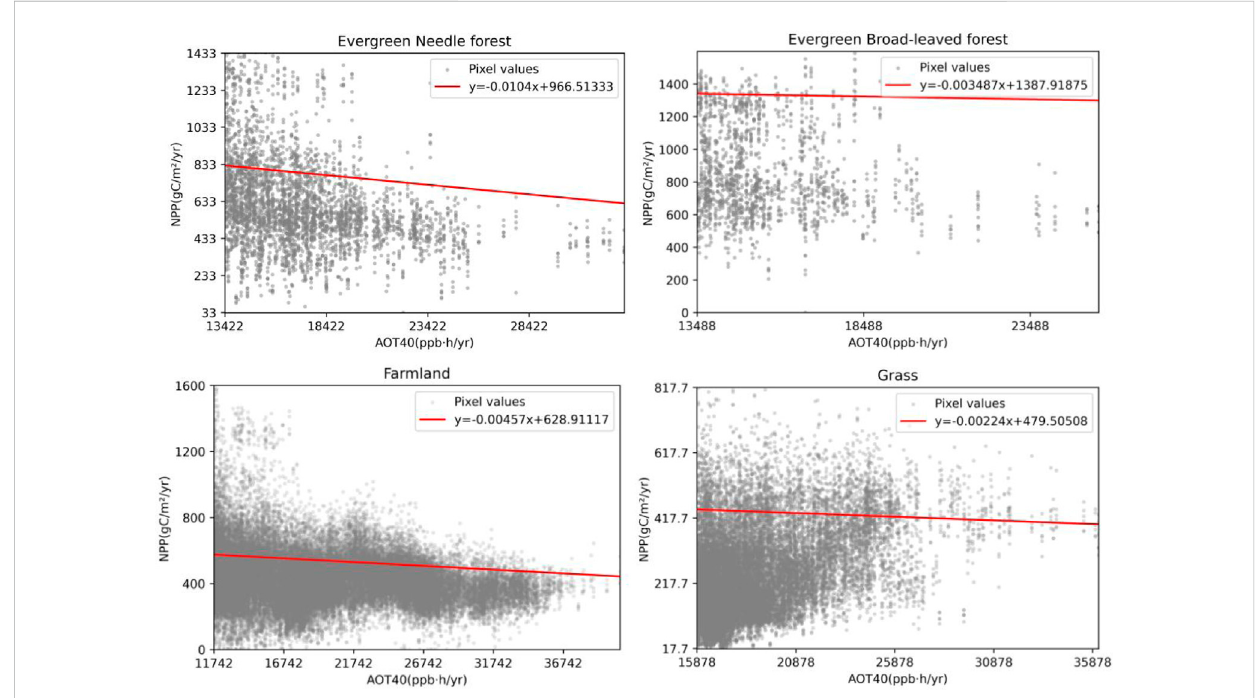
6-year scatter plot and response relationships fi tted line of annual NPP and annual AOT40 of four ecosystems.